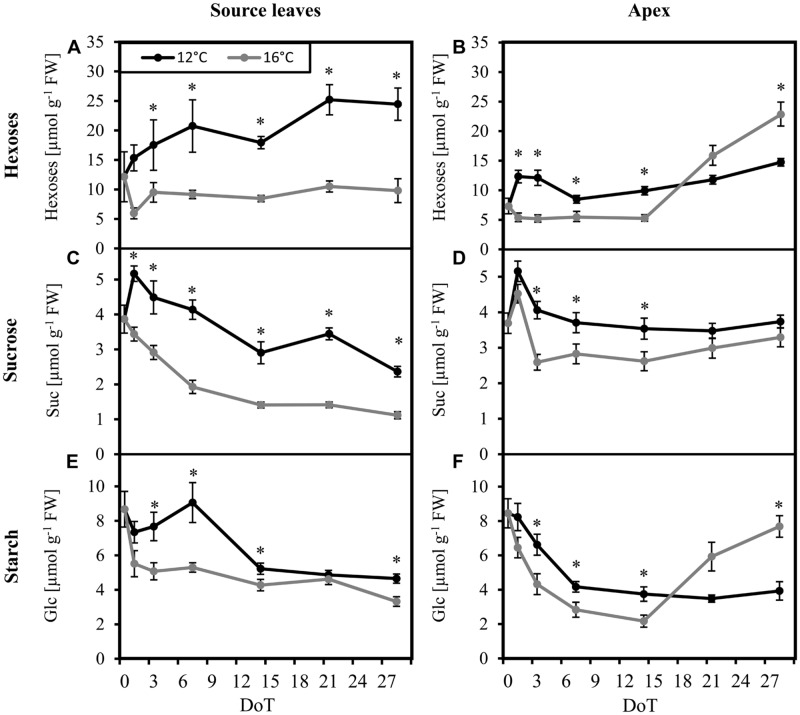
Carbohydrate levels. Impact of sub-optimal temperature (black: 12°C, gray: 16°C) on carbohydrate levels. (A) source leaves, hexoses; (B) apex, hexoses; (C) source leaves, sucrose; (D) apex, sucrose; (E) source leaves, starch [specified in units of glucose (Glc)]; (F) apex, starch (specified in units of Glc). (DoT = days after differentiation of temperature; n = 12; data are means ± SE; asterisks indicate significant differences between temperature treatments for a given sampling time, P ≤ 0.05).